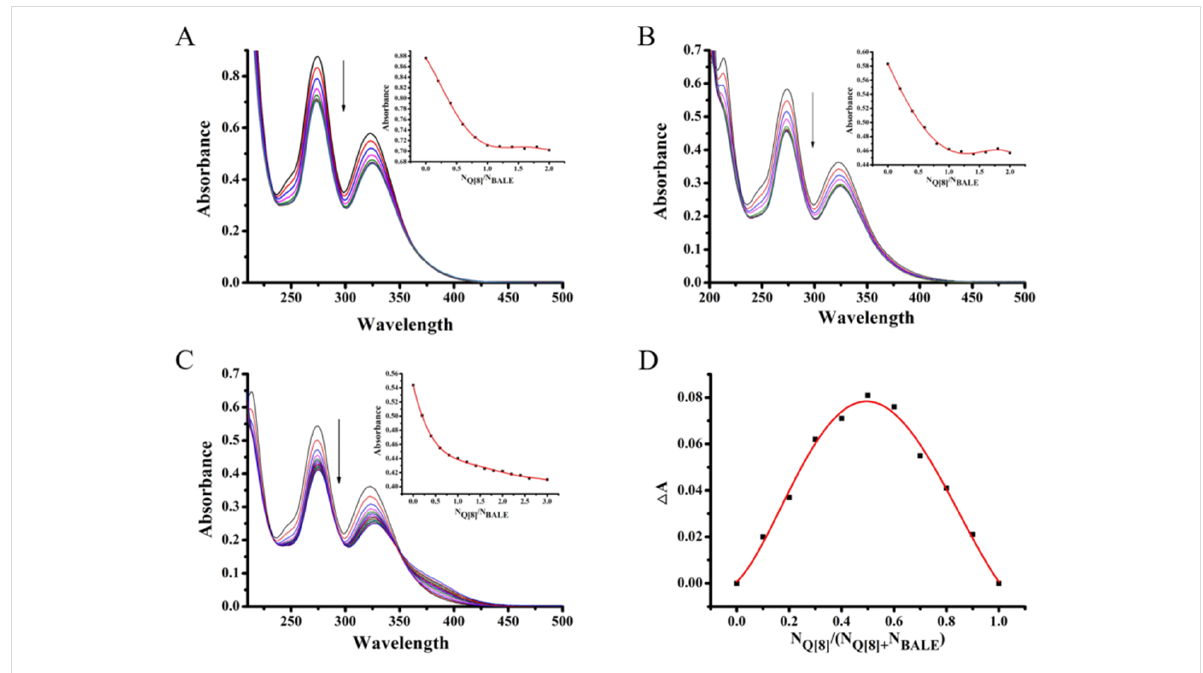
Figure 4: The absorption spectra of BALE upon the addition of Q[8] under different conditions [10 mol·L − 1 HCl (A), 10 − 2 mol·L − 1 HCl (B) and water(C)]; Job’s plot of A vs N Q [8]/N Q [8] + N BALE (D).